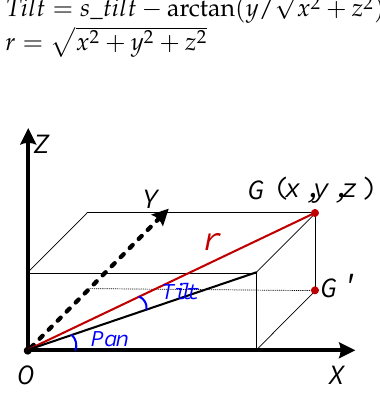
Figure 15. The diagram of 2DOF rotation angle of PTZ camera.